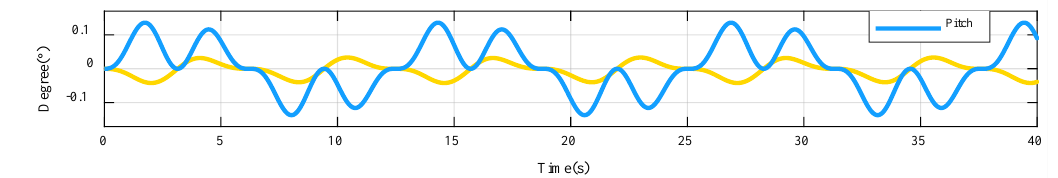
Figure 30. Rolling value and pitching value of the R-deck of the compensation platform. The maximum rolling angle is less than 0.34 degrees and the biggest pitch angle is 0.136 degrees. Both are drastically less than the revolute movement of the vessel.